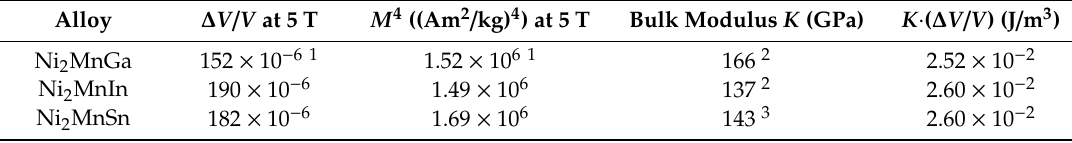
Table 2. The forced volume magnetostriction ∆ V / V at 5 T and the bulk modulus. Alloy ∆ V / V at 5 T M 4 ((Am 2 / kg) 4 ) at 5 T Bulk Modulus K